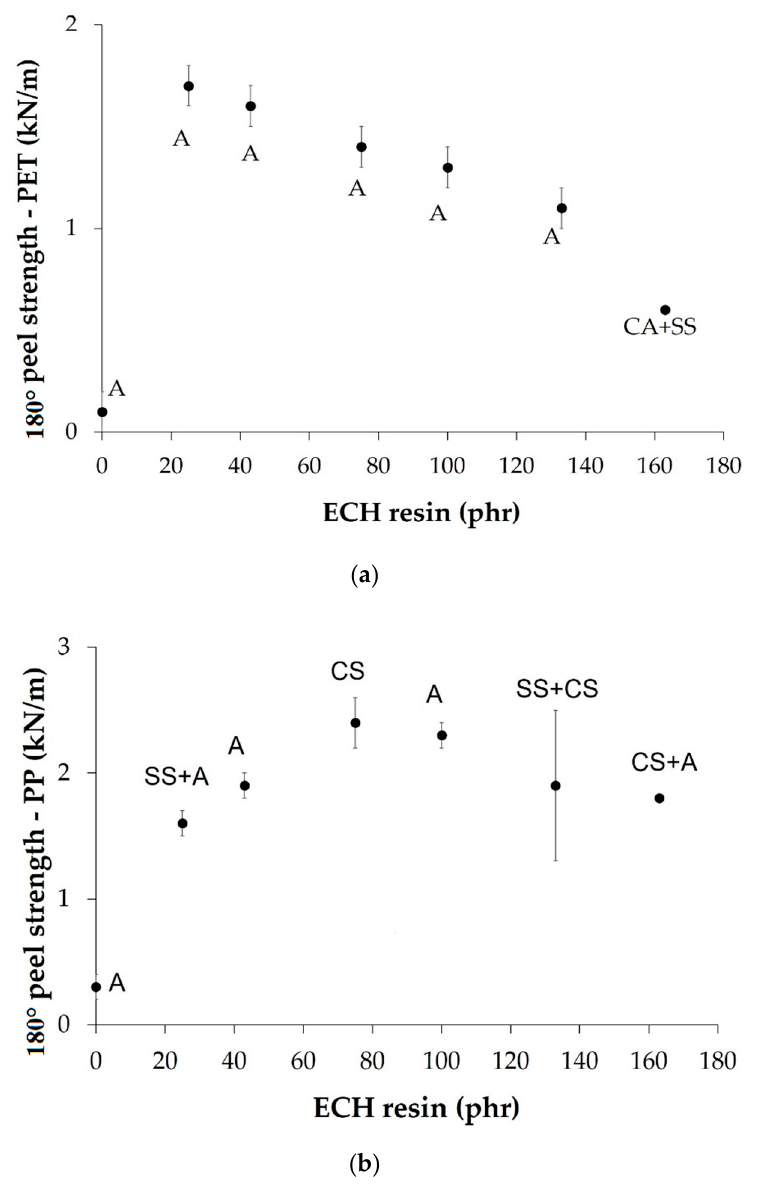
Figure 15. ( a ) Variation of the 180° peel strength of aluminum/EBA copolymer or EBA copolymer + ECH resin blend/PET film joints as a function of the amount of ECH in the binary blend. Locus of failure: A: Adhesive failure to PET film, CA: Cohesive failure of the adhesive, SS: Stick-slip. ( b ) Variation of the 180° peel strength of aluminum/EBA copolymer or EBA copolymer + ECH resin blend/PP film joints as a function of the amount of ECH in the binary blend. Locus of failure: A: Adhesive failure to PP film, CA: Cohesive failure of the adhesive, SS: Stick-slip, CS: Cohesive failure of PP film.